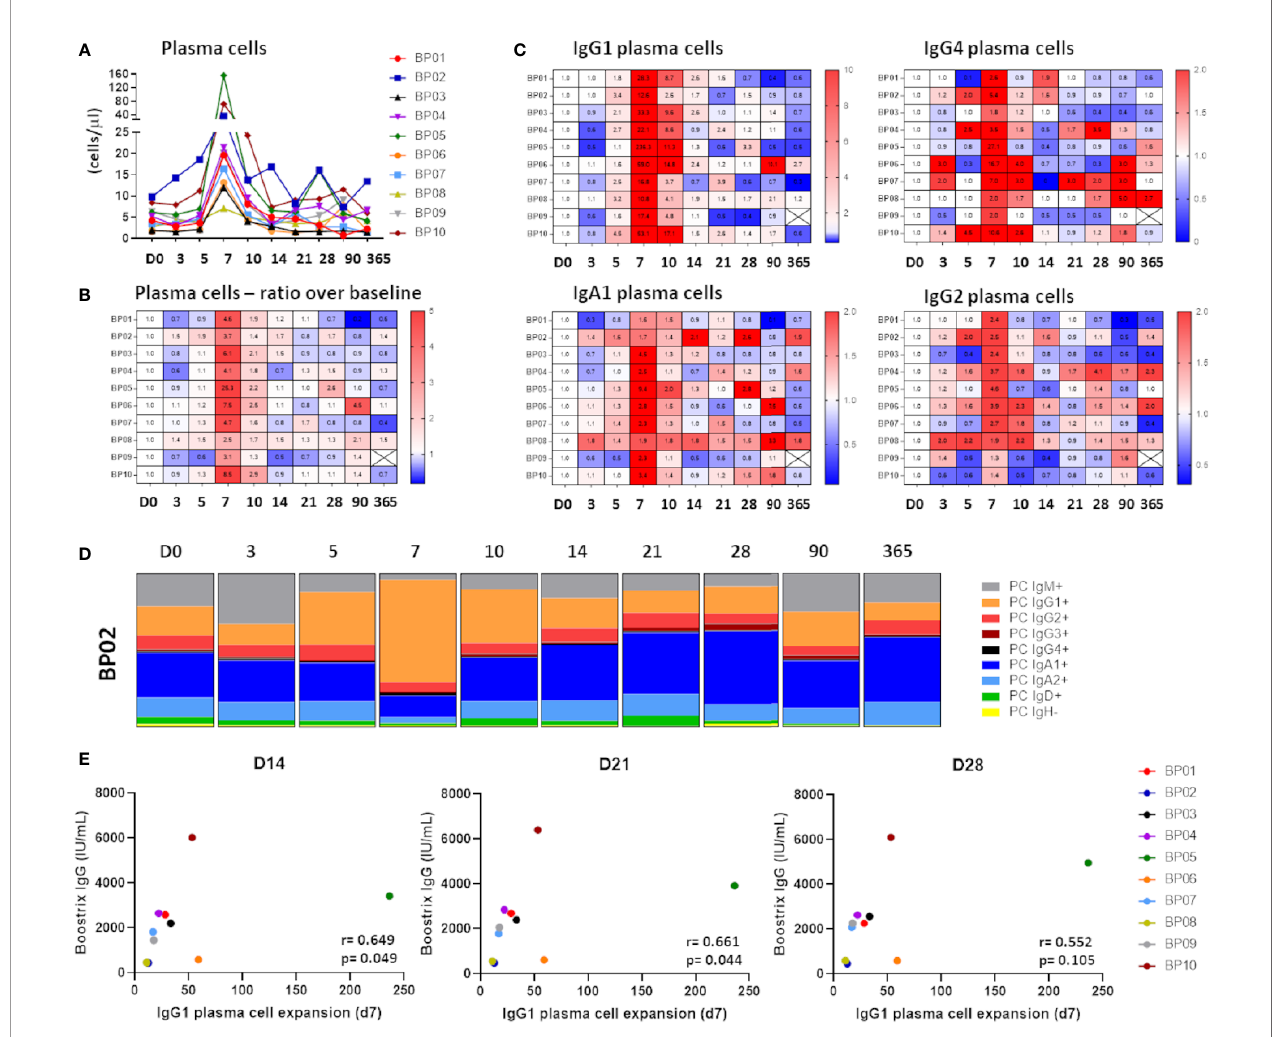
FIGURE 3 | Kinetics in the plasma cell compartment upon immunization with aP booster. (A) Maximum expansion of plasma cells at day 7 (up to 156 cells/µl). Expansion started at day 5, peaked at day 7 and returned to baseline afterwards. (B) Heatmap representing the expansion of plasma cells in ratio over baseline. (C) Heatmaps representing the expansion of different plasma cell subsets. Only the most prominent expansions were visualized: IgG1 plasma cells (11-236x), IgG4 plasma cells (2-27x), IgA1 plasma cells (1.6-10.4x) and IgG2 plasma cells (1.3-4.6x). (D) Fluctuations in the distribution of the plasma cell compartment over time. One representative donor is shown. Majority of the expanded plasma cells was of IgG1 phenotype (min-max in donors: 44% -76%). (E) Correlation between maximum plasma cell expansion (day 7) and the level of vaccine-speci fi c IgG ( “ Boostrix-IgG ” ) at days 14, 21 and 28 as determined by Spearman ’ s rank correlation. An FDR-corrected p-value of <0.0075 was considered signi fi cant. D, Days after